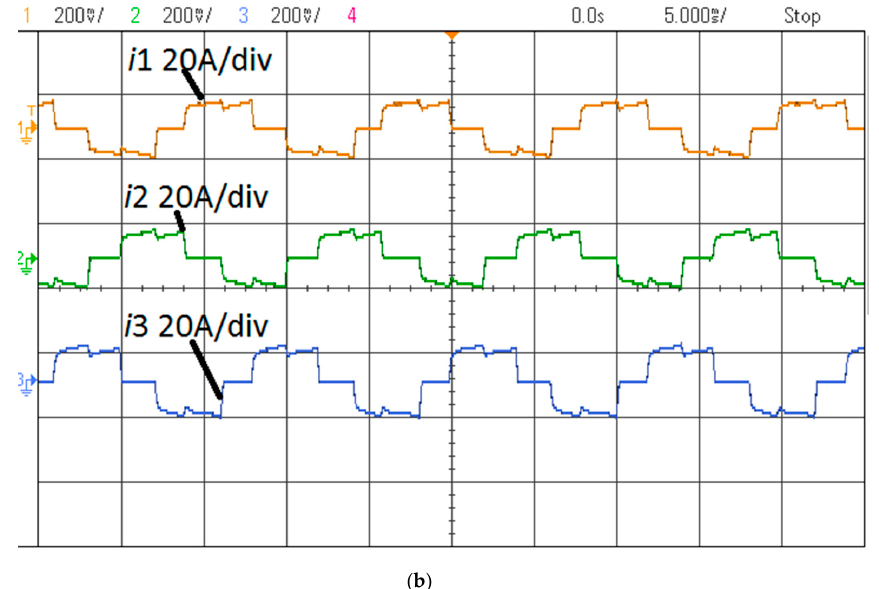
Figure 8. Star (Y) configuration—waveforms of line currents in healthy mode: ( a) numerical calculations; ( b ) measurements.